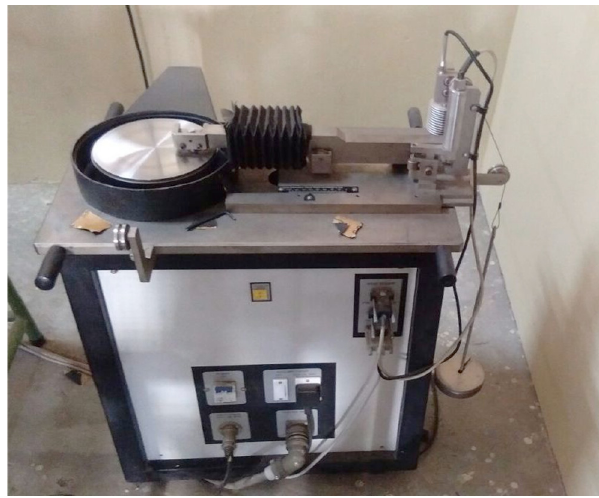
Fig. 1. Pin on disc apparatus.